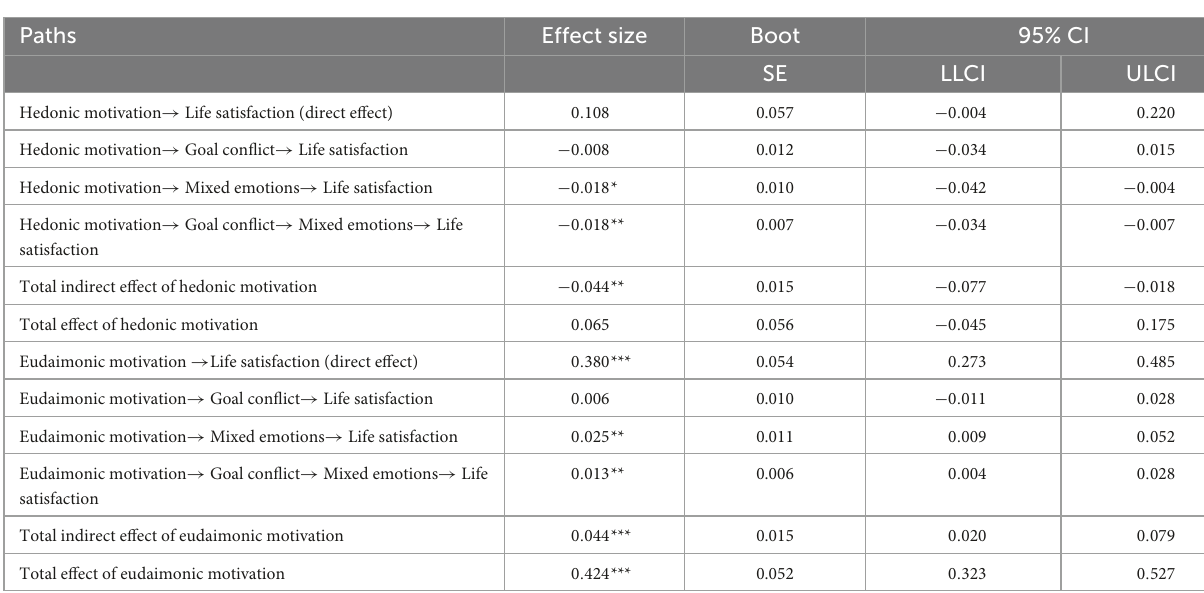
TABLE 2 Mediating effect